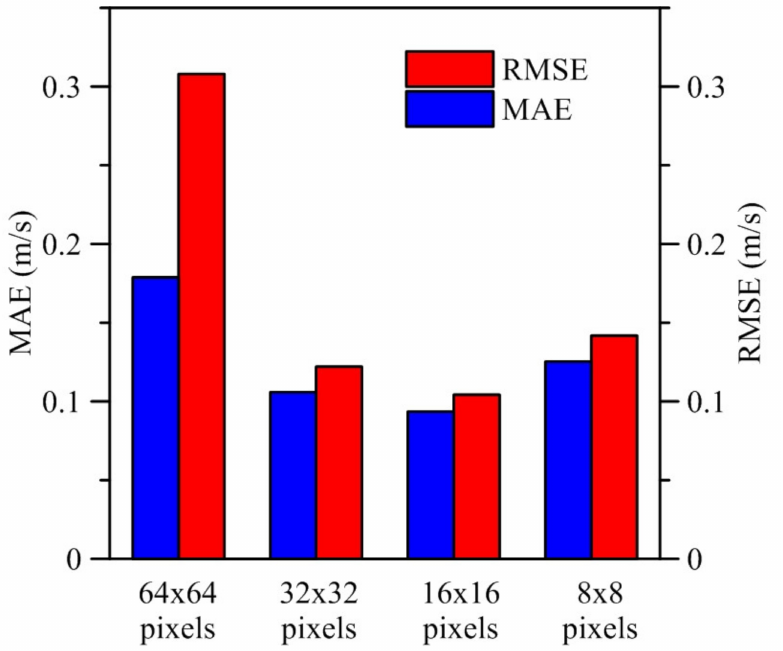
Figure 11. The statistical errors of surface velocity for different interrogation